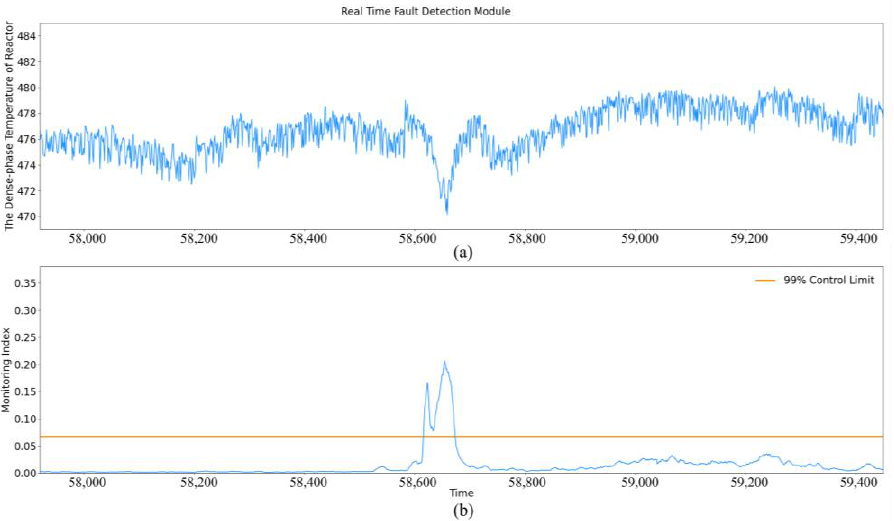
Figure 10. Process monitoring result on case one obtained by the proposed method: ( a ) Original data of the key variable; ( b ) Fault detection results.